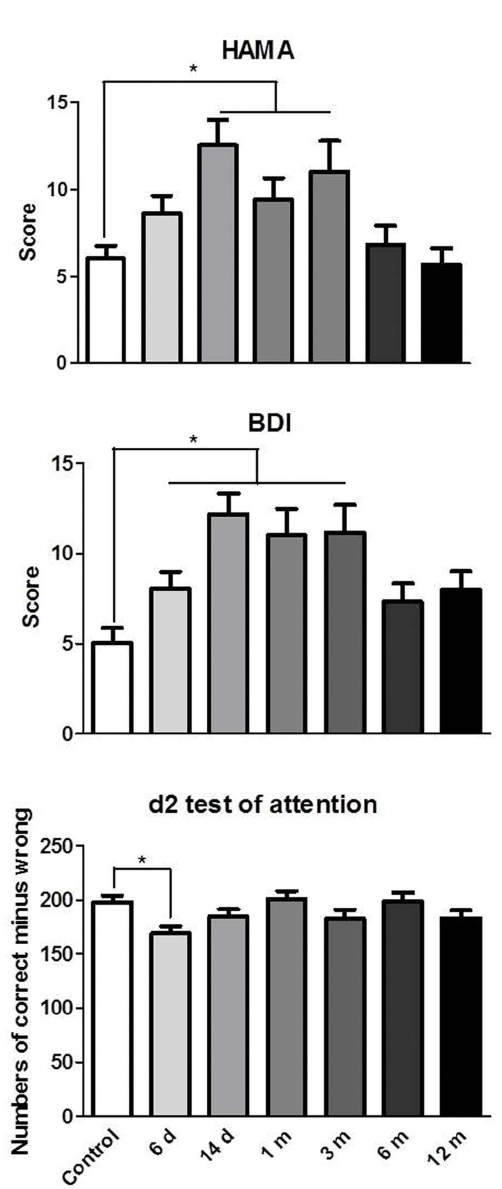
Figure 2. Anxiety, depression, and attention in the subjects. * p , 0.05, significant difference between METH abusers and healthy controls.